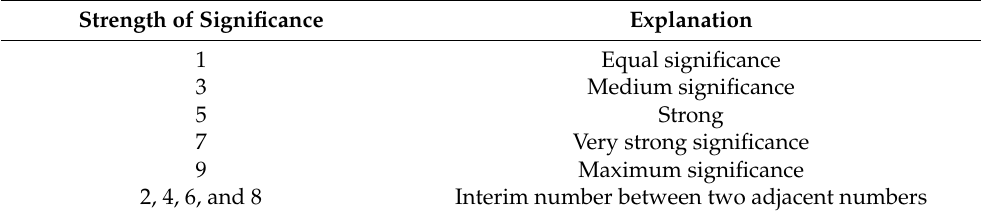
Table 3. The one-to-nine scale of parameters significance